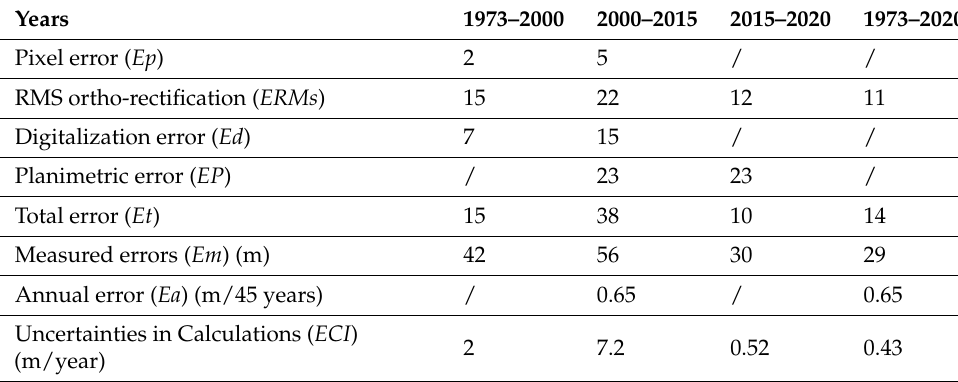
Table 3. Errors related to the erosion model on the Kribi coast.